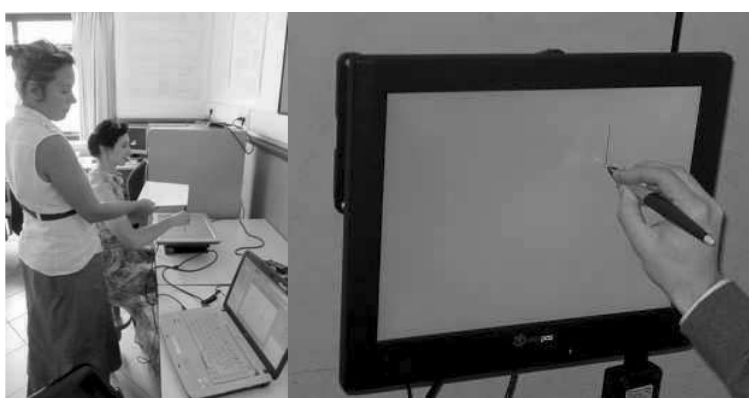
Fig. 1. The DP-TC test. Source: Photos by Plotka A., & Liutsko L. (Own